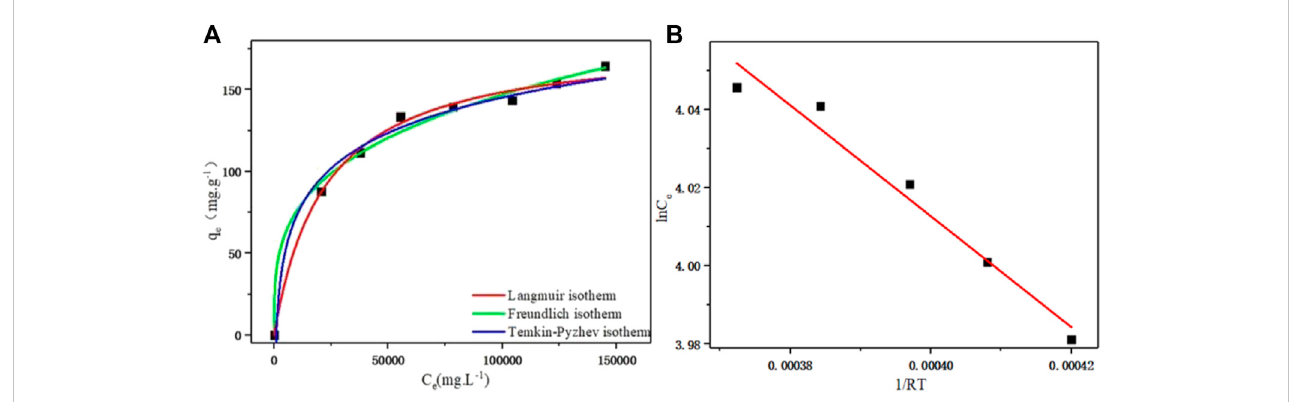
FIGURE 3 (A) Langmiur, Freundlich, and Temkin-Pyzhev adsorption isothermal curves of D152 cation exchange resin for PDA. (B) Linear fi t of the Clapeyron- Clausius equation.